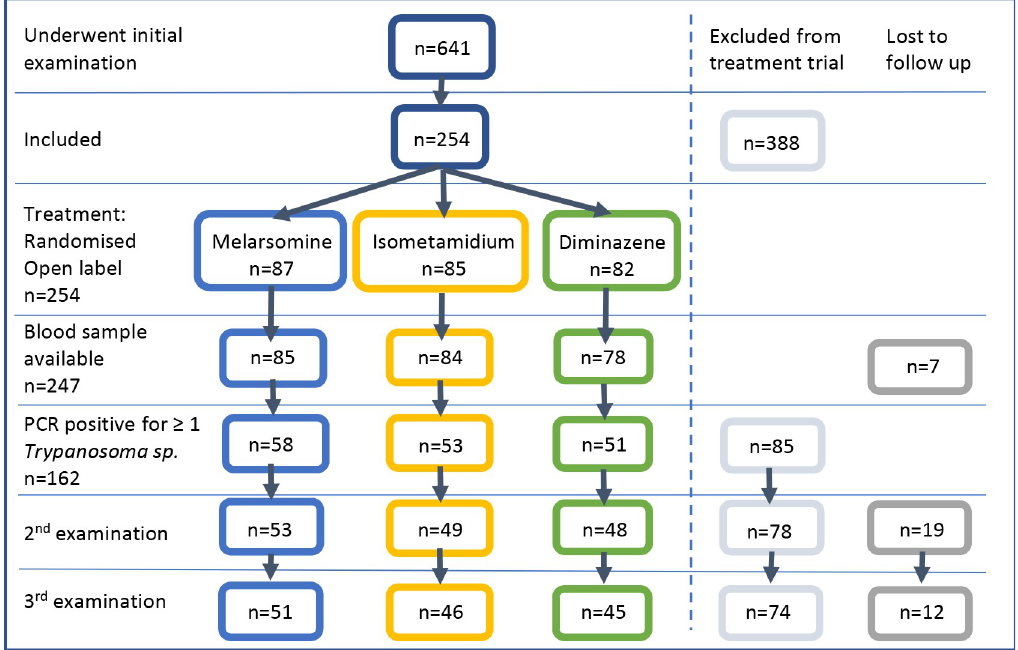
Fig 1. Flow chart illustrating recruitment of equines to the treatment study. Of the 254 animals which fulfilled clinical criteria for inclusion in the study, 162 subsequently proved PCR positive for at least one Trypanosoma sp. and were included in the treatment trial (n = 162). Animals that were PCR negative for all Trypanosoma sp. at the first examination were excluded from the treatment trial (n = 85). Adverse drug reactions were documented for the whole treated population (n = 254). Animals which fulfilled the clinical criteria for which PCR status was known (n = 247) were used to document the number of new or recrudescence of existing infections within treatment groups. Colours correspond to treatment group (blue = melarsomine, yellow = isometamidium, green = diminazene), exclusion (grey) or loss to follow up (dark grey) of animals.